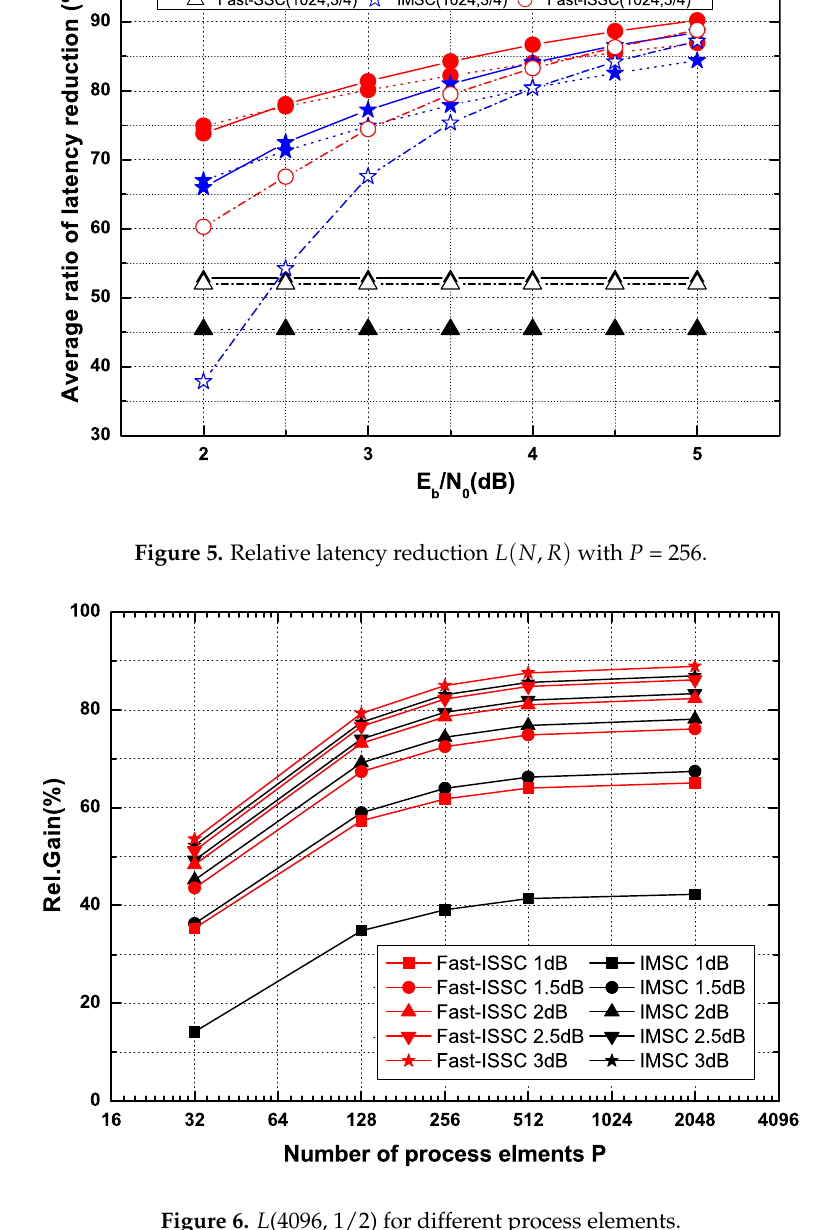
Figure 6. L (4096, 1/2) for different process